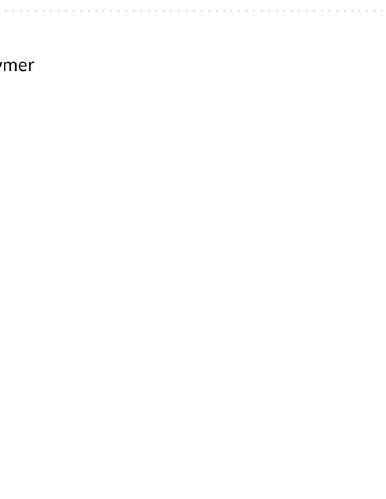
Figure 9. The silver containing SPEs at the interface zone after use ( A ) silver only based SPE and ( B ) Silver and Carbon SPE.